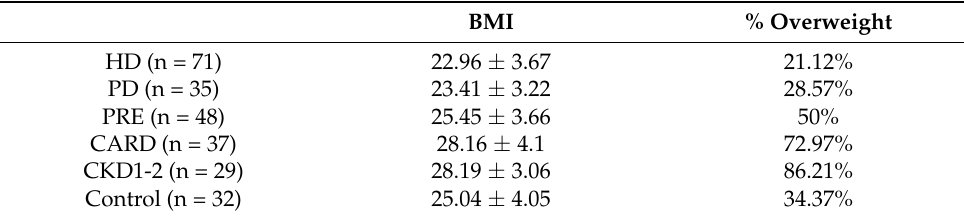
Figure 2. Dialysis duration and mortality within the groups: ( A ) the boxplot illustrating dialysis treatment duration with distinction of hemodialyzed (HD) and peritoneal dialyzed (PD) patients; ( B ) the barplot depicting the percent of deceased patients in every group with 2 year follow up; ( C ) the scatterplot presenting relation of age and number of months survived for dead patients, additional regression line was added to clarify the image and show lack of correlation (Spearman ρ = − 0.075, p = 0.7194). Table 2. Basic information about body mass index (mean ± standard deviation) and obesity (percent of overweight patients) within the